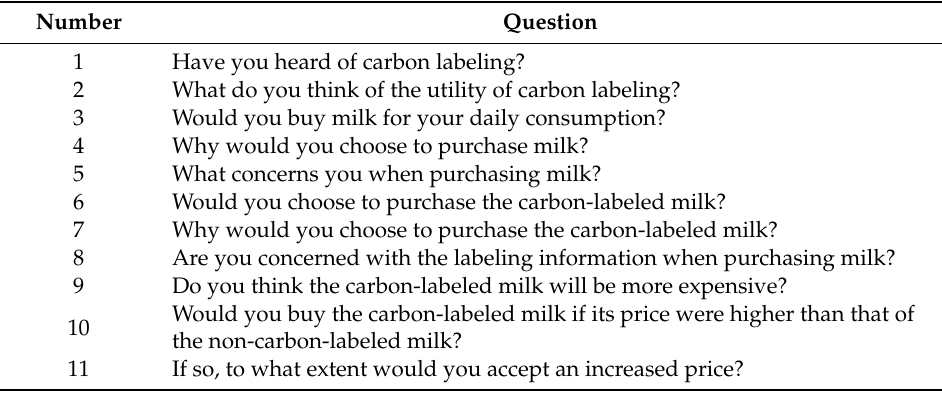
Table 2. Question design for the focus